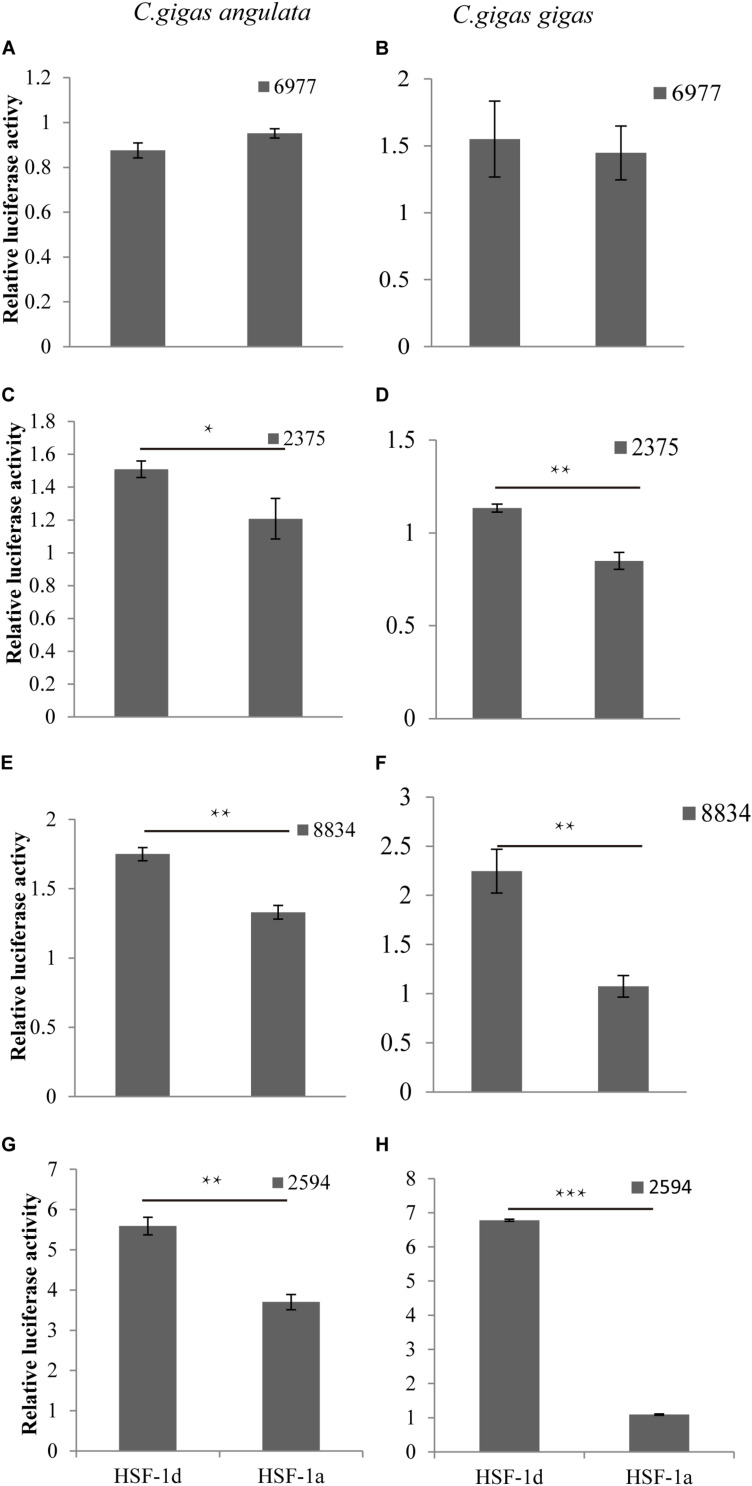
The regulatory of subtypes and the HSPs in C. gigas gigas and C. gigas angulata by dual Luciferase assay. (A,B) Relative luciferase activity of HSF1 isoforms with 6977(CGI_10006977) active in the Pacific and Fujian oysters, respectively. (C,D) Relative luciferase activity of HSF1 isoforms with 2375(CGI_10002375) active in Pacific and Fujian oysters, respectively. (E,F) Relative luciferase activity of HSF1 isoforms with 8834(CGI_10008834) active in the Pacific and Fujian oysters, respectively. (G,H) Relative luciferase activity of HSF1 isoforms with 2594(CGI_10002594) active in the Pacific and Fujian oyster, respectively. The horizontal axis represents HSF1d and HSF1a, and the vertical axis represents the relative luciferase activity of the target plasmid (HSF1d or HSF1a). The left column is under HSF1d activation while the right one is under HSF1a activation. Error bars denote the standard error of the mean. *0.01 < p < 0.05, **0.001 < p < 0.01, ***p < 0.001.